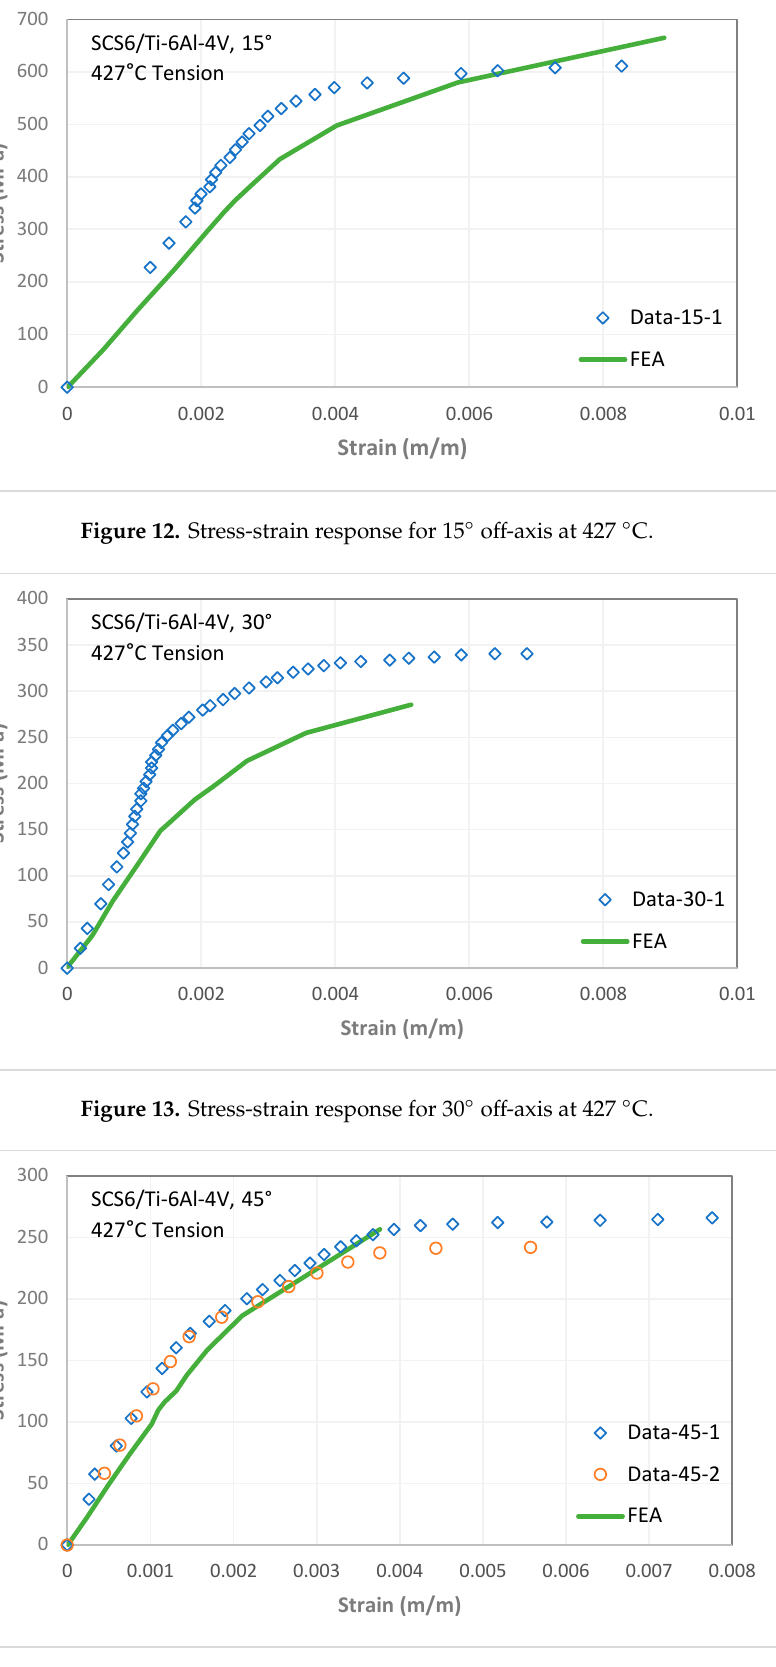
Figure 14. Stress-strain response for 45° off-axis at 427 °C.